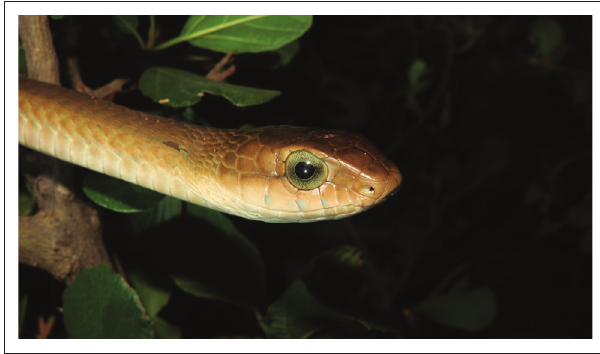
Source : Photo courtesy of patient. FIGURE 1 : Culprit boomslang: A 1.2 m adult